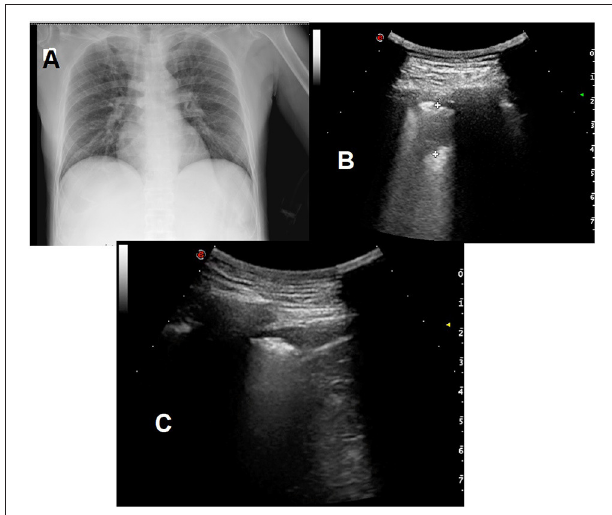
FIGURE 2 | (A) Antero-posterior bedside X-ray showing no pulmonary consolidation and no apparent pleural effusion. (B) Posterior left basal LUS scan showing a small subpleural thickening of 1.5cm. (C) hypoechoic consensual homolateral pleural effusion (depth: 9mm) in the diaphragmatic costophrenic